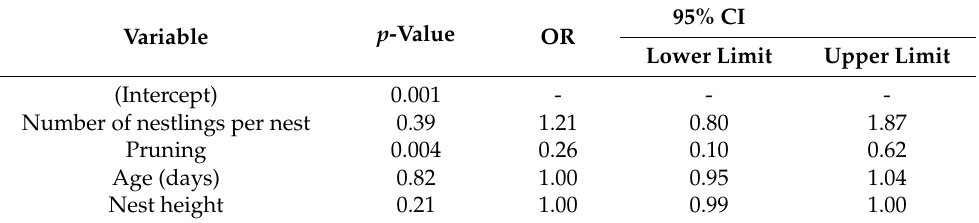
Table 4. Final model results from the multivariate logistic regression analysis. Category, p -value, odds ratio, and 95% confidence interval (CI) lower and upper limit are reported for the variables that were retained in the model showing an association or relevance on the positivity to protozoan agents ( Cryptosporidium spp. and Giardia spp.) on Monk Marakeet